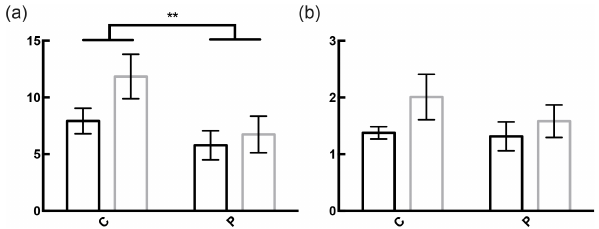
Figure 5. Means of (a) the N:P ratios and (b) N:K ratios for Sphagnum squarrosum (dark bars) and S. palustre (grey bars), dis- played for control (C) and addition of P (P) to surface water. Given is the mean ± SE of the mean (N = 4). HCO 3 treatments were not included, because of leaking of nutrients from tissue (see text). Sig- nificant differences between treatments are shown with ∗∗ P< 0 . 01 in the